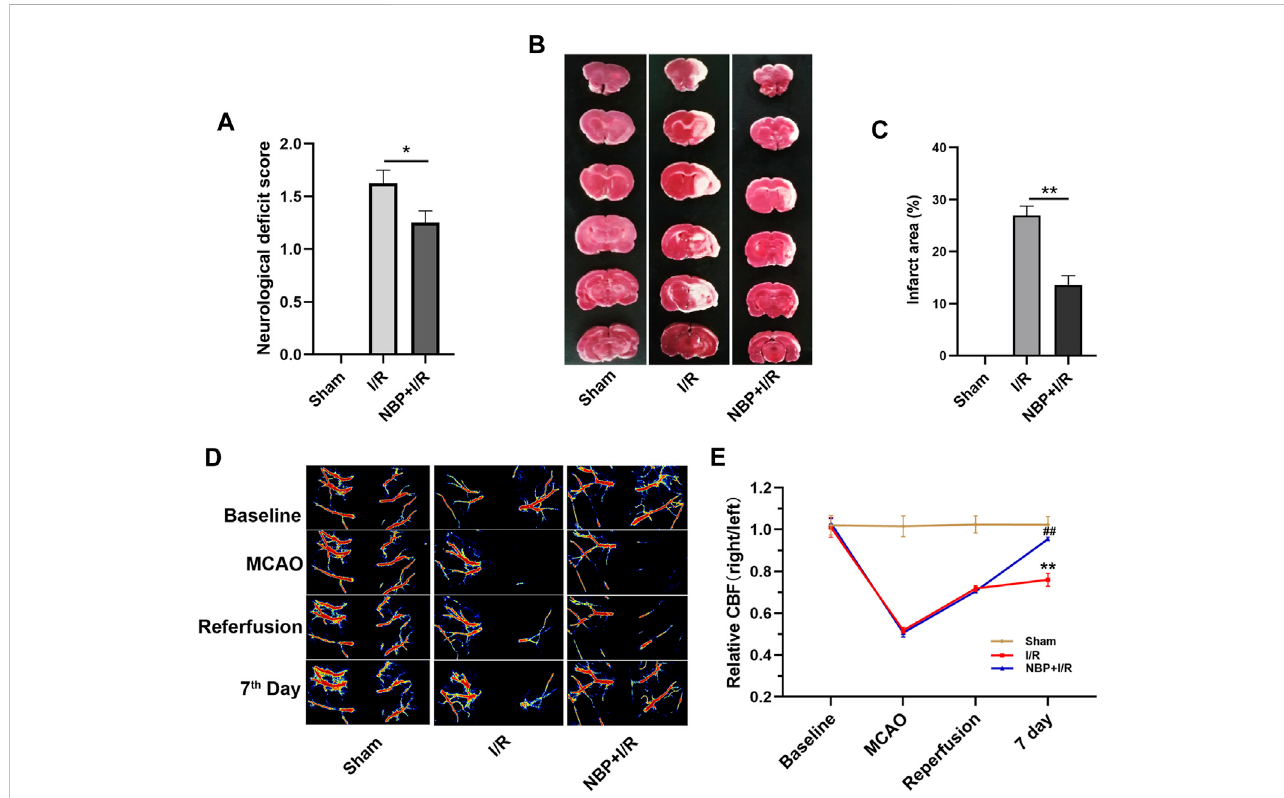
Effects of NBP on neurological scores, cerebral infarction and CBF in I/R rats. (A) Effects of NBP on neurological scores (n = 16). Rats showed obvious neurological de fi cits after I/R surgery, while NBP treatment signi fi cantly improved neurological function. (B and C) Effects of NBP on the infarct area in the right hemisphere of the brains in I/R rats (n = 3). I/R surgery resulted in obvious infarction in the right hemisphere of the brain, while NBP signi fi cantly reduced the infarct area inI/R rats. (D and E) Effects of NBP on CBF and the ratio of CBF in the right hemisphere to the left hemisphere (n = 3). Data are expressed as the mean ± SEM and were analyzed by one-way ANOVA ( post hoc analysis: Tukey ’ s post hoc analysis test). *( p < .05) and ** ( p < .01) represent signi fi cance compared to the I/R group. ## ( p < .01) represents signi fi cance compared to the sham group. NBP dose: NBP + I/R, 9